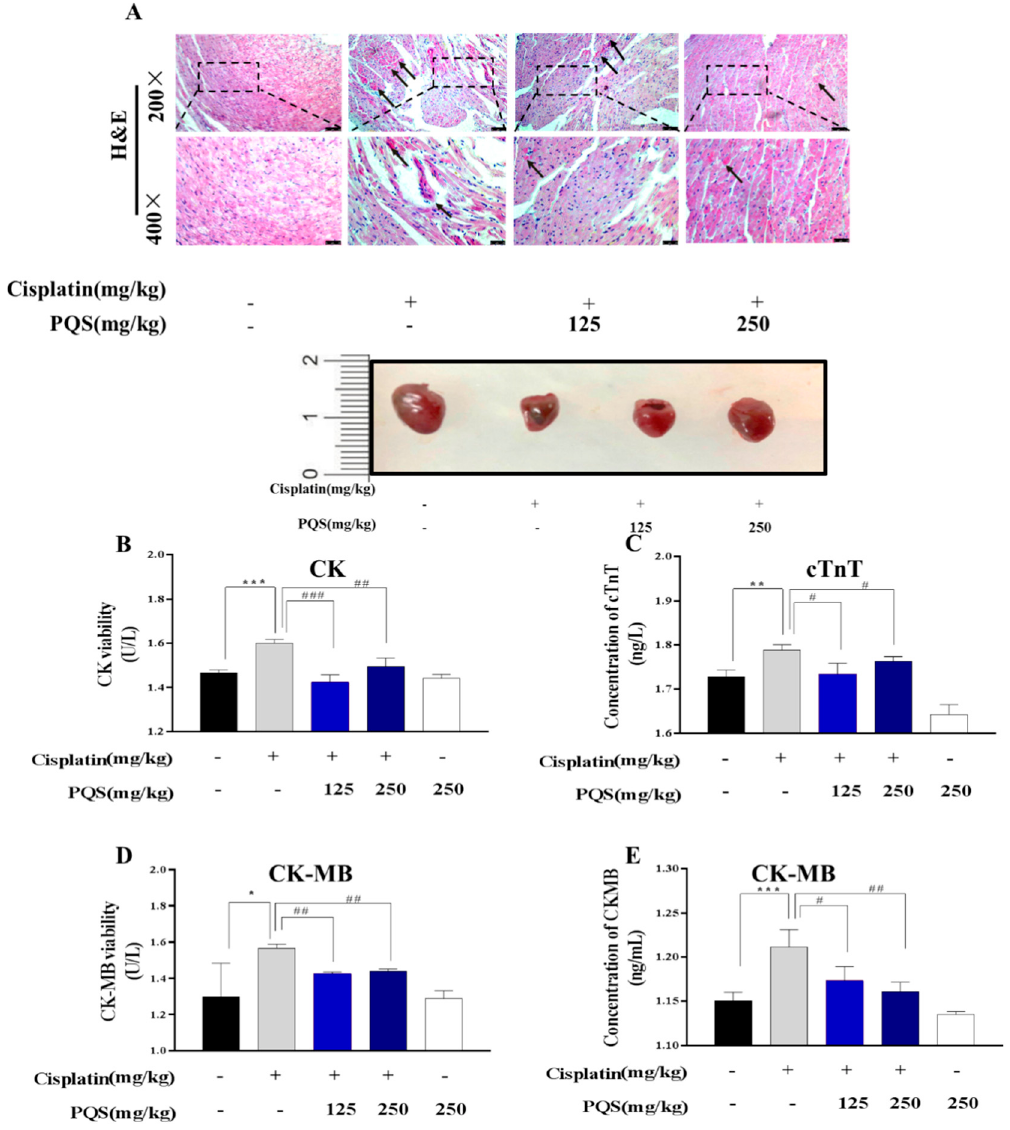
Figure 2. Effect of PQS on cisplatin-induced changes in heart tissues of mice ( A ). Cisplatin + PQS (125 mg/kg), Cisplatin + PQS (250 mg/kg) groups (H&E × 200). Effects of cisplatin and PQS on the serum levels of related markers CK ( B ), cTnT ( C ), viability of CK-MB ( D ), and concentration of CK-MB ( E ). All data were expressed as mean ± S.D. * p < 0.05 or ** p < 0.01 or *** p < 0.01 comparing with normal group. # p < 0.05 or ## p < 0.01 or ### p < 0.01 comparing with cisplatin group.